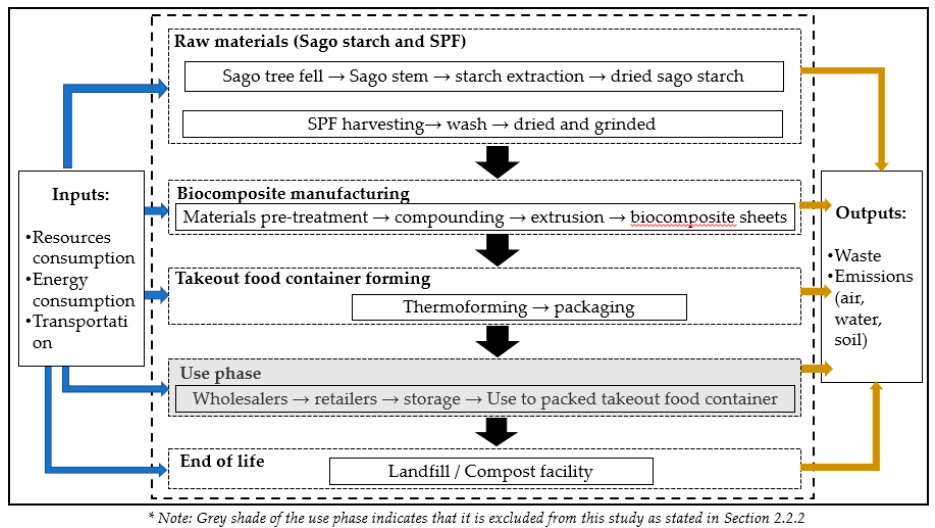
Figure 2. System boundary under investigation for the SPF-reinforced sago starch biocomposite takeout food